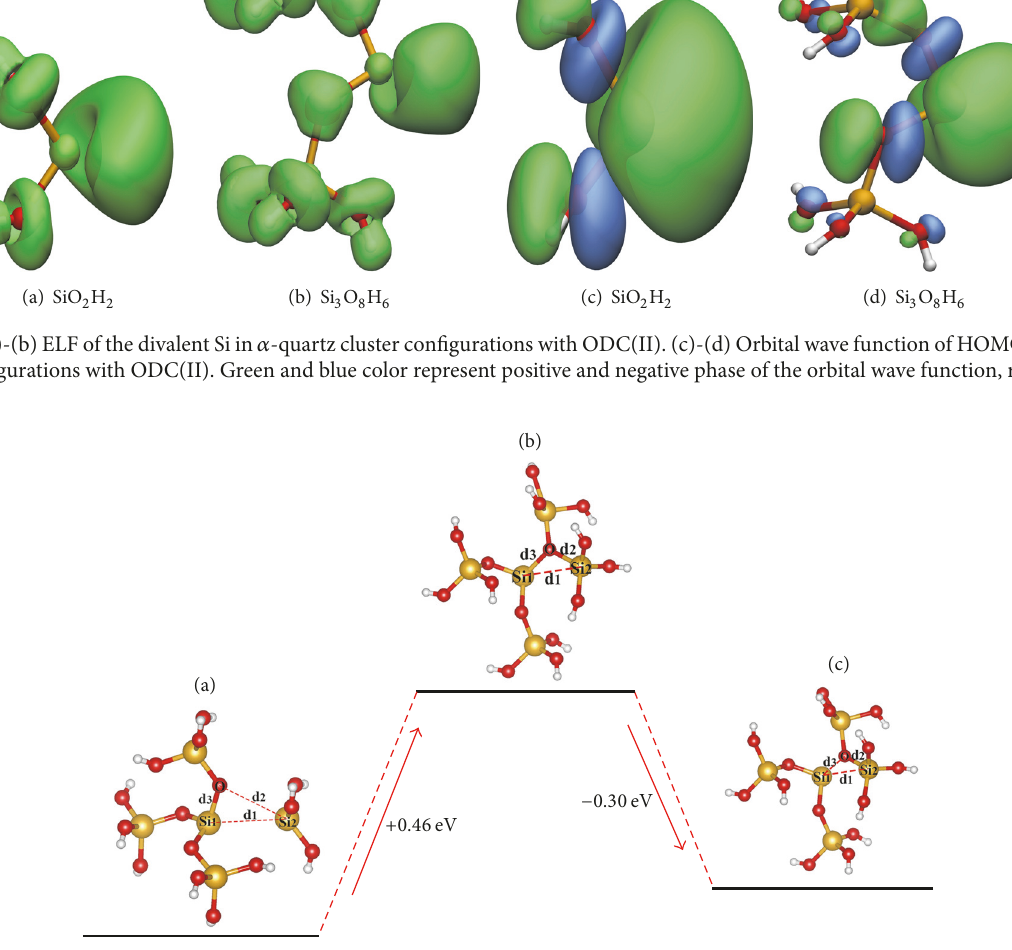
𝑑1 = 3.07 ˚A, 𝑑2 = 1.64 ˚A, and 5 O 15 H 12 cluster with ODC(II),